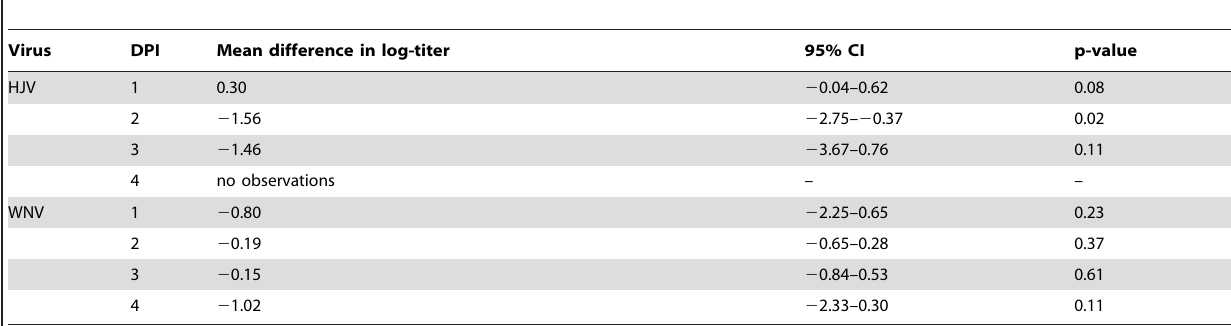
Table 4. Individual comparisons by virus and day post inoculation (DPI) of mosquito-sampled log-titer to syringe-sampled log-titer using the paired t-test and associated 95% CI.